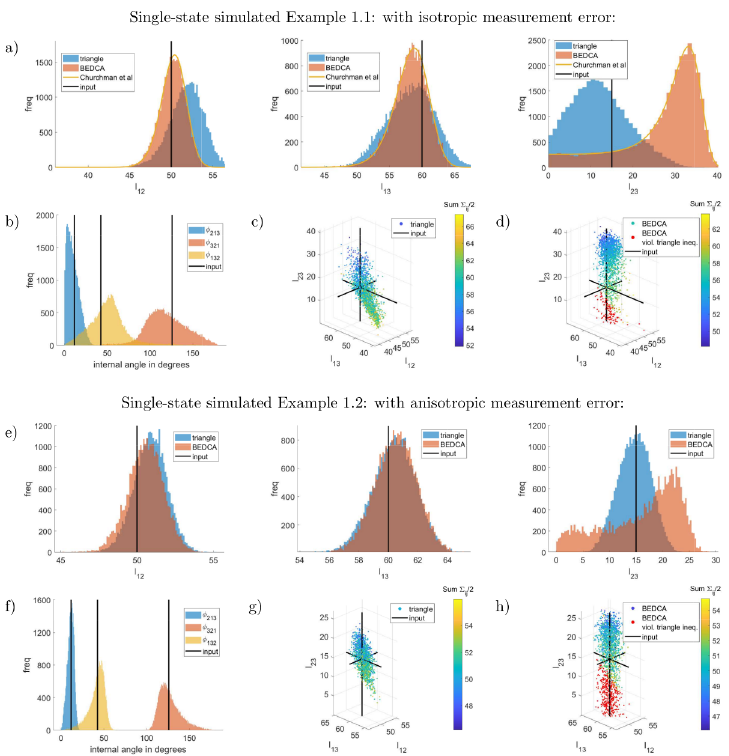
Fig 3. Posterior distributions for single-state simulated Examples 1.1, 1.2. Marginal inferred posteriors for lengths (in nm) and internal angles. For each example the top row (a,e) shows the marginal posteriors of the three triangle lengths as inferred by each of the correction methods. The bottom left images (b,f) show the inferred internal angles using the triangle correction presented here. The bottom centre images (c,g) show a scatter plot of the joint distribution as obtained with the triangle correction. The bottom right images (d,h) show the naive attempt to achieve a joint distribution of the three triangle lengths from the BEDCA method [9] by assuming independence. Samples that violate the triangle inequality are shown in red (about 7% of the samples in Example 1.1, 22% in Example 1.2), otherwise the colour represents the sum of all measurement errors, specifically correlation between inferred lengths and errors. The plots show random sub-samples, to improve visibility. See Table 1 for the posterior means and standard deviations. See section Additional supplementary images in S1 Text for the corresponding Markov chain evolution of the parameters of the triangle